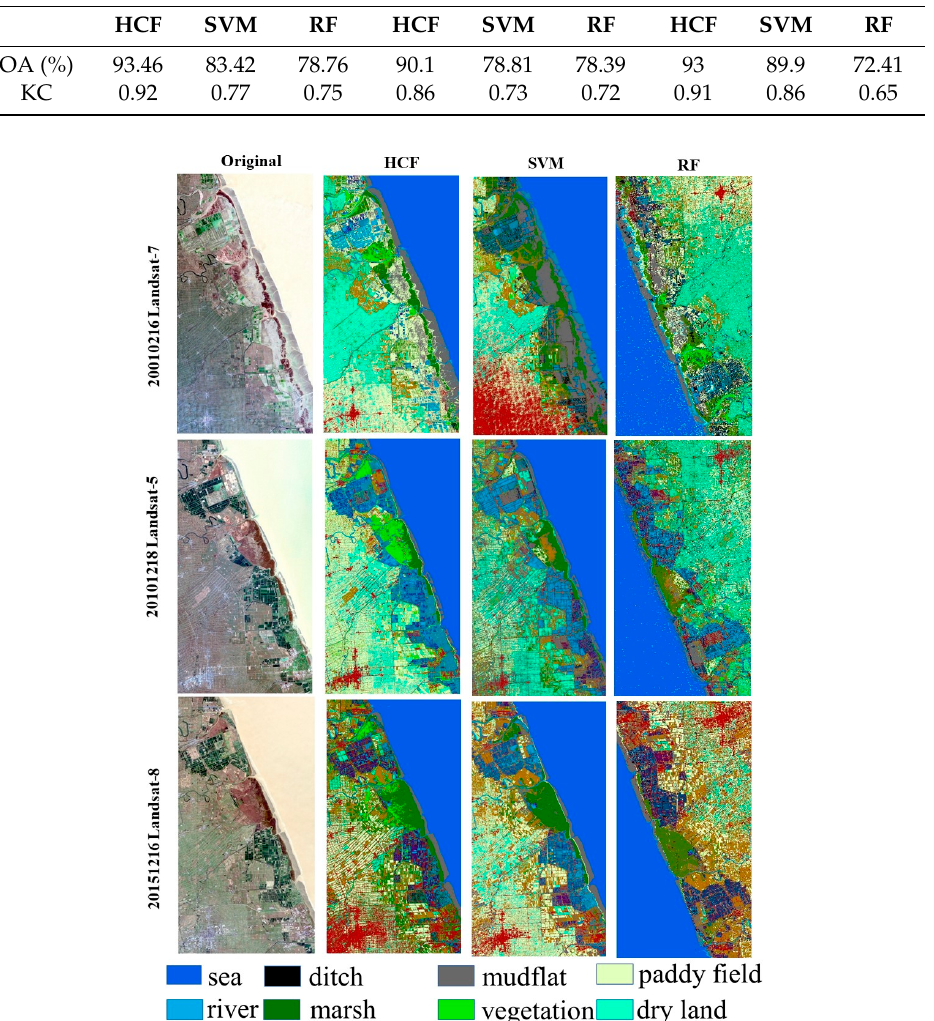
Table 6. Classification accuracies of HCF, SVM and RF on Landsat data of Yancheng coastal wetland.